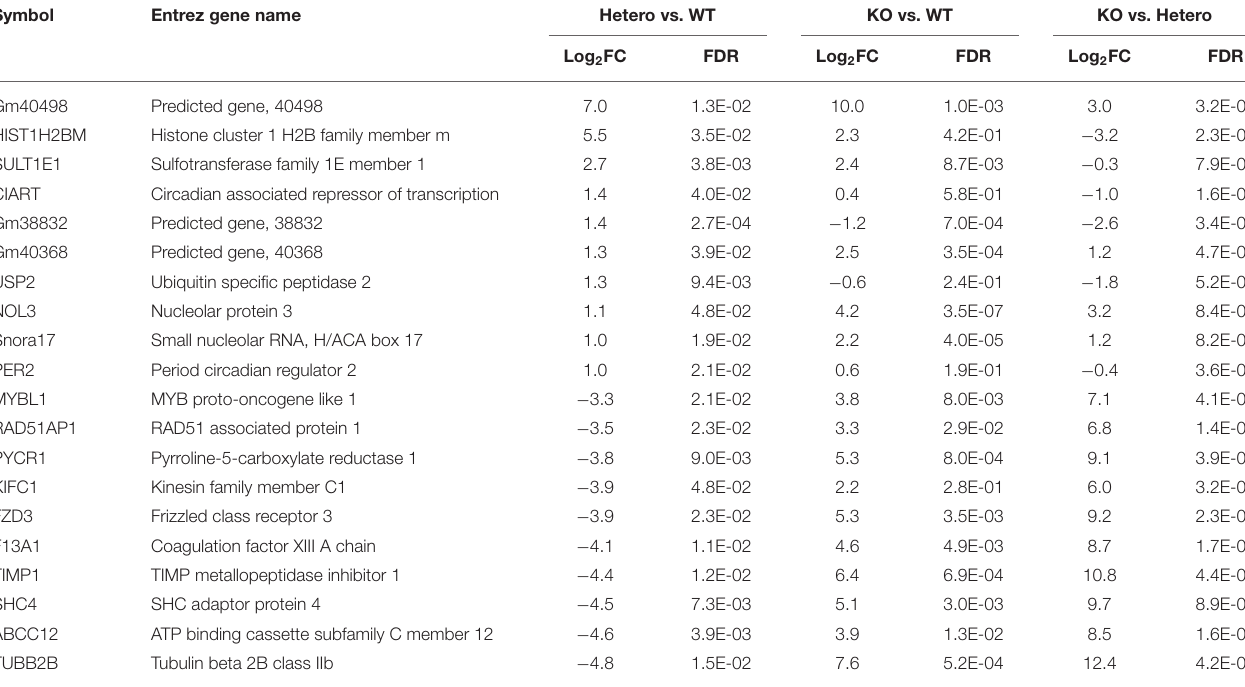
TABLE 1 | The 20 most differentially expressed genes, comparing between Phb1 + / − vs. WT, Phb1 − / − vs. WT, and Phb1 − / − vs. Phb1 + / − .